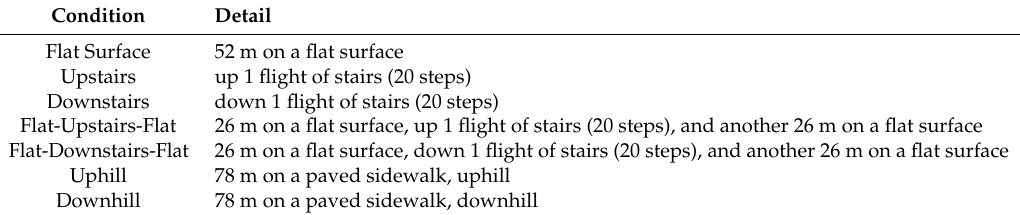
Table 1. Various terrain scenarios tested for each